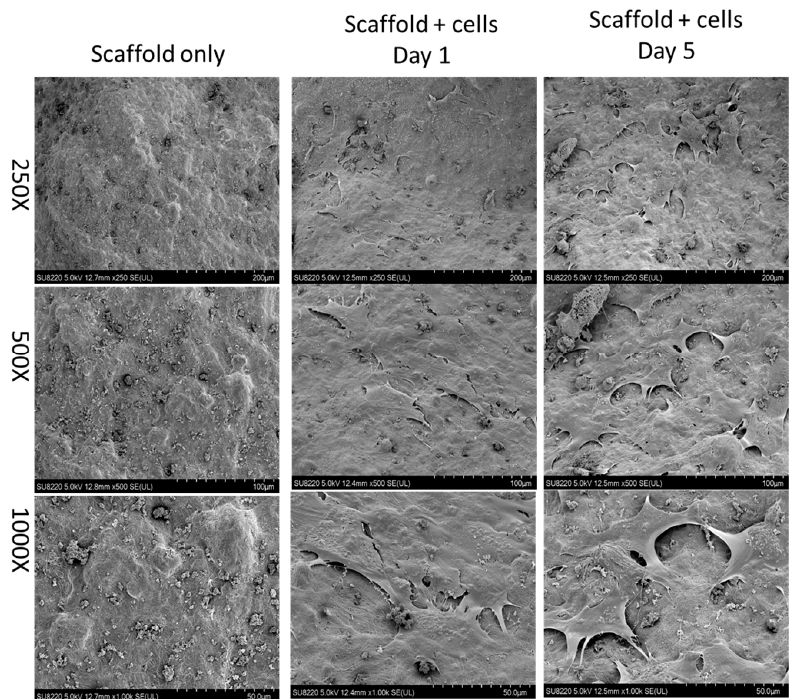
Figure 2. A scanning electron micrograph demonstrates the scaffold without cells and the scaffold with cells (Baculo-BMP-7-BMDMSCs). This image shows that the cells were successfully seeded onto the scaffold.